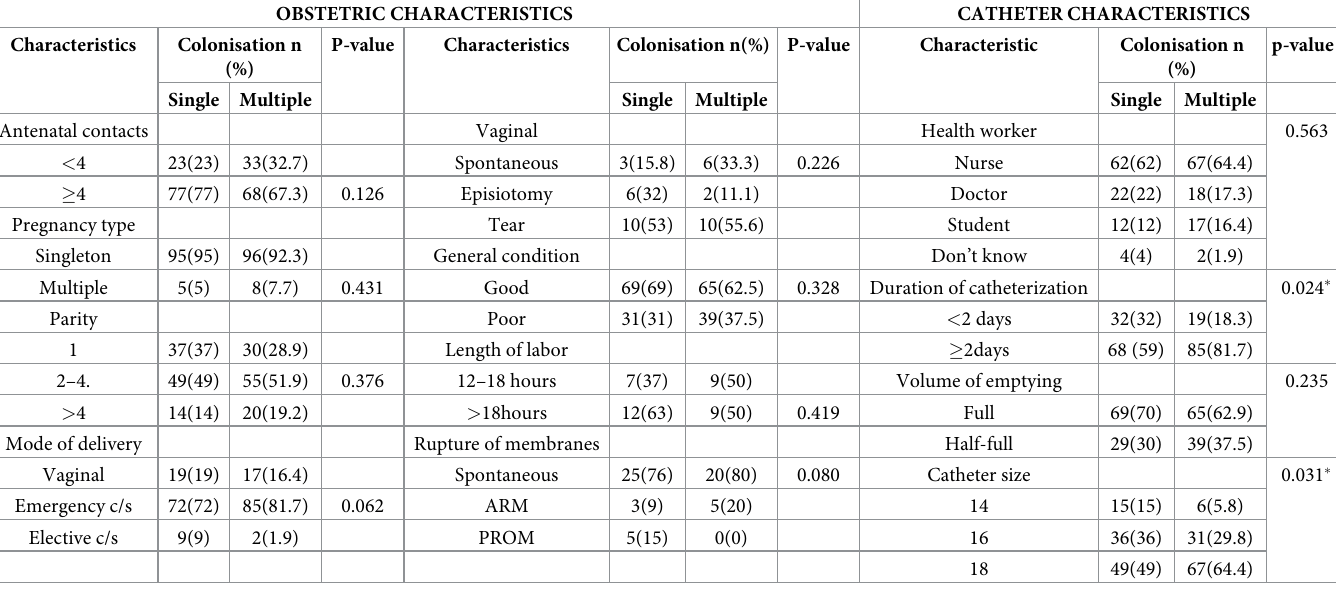
Table 4. Showing association of obstetric characteristics and catheter characteristics with bacterial species diversity.